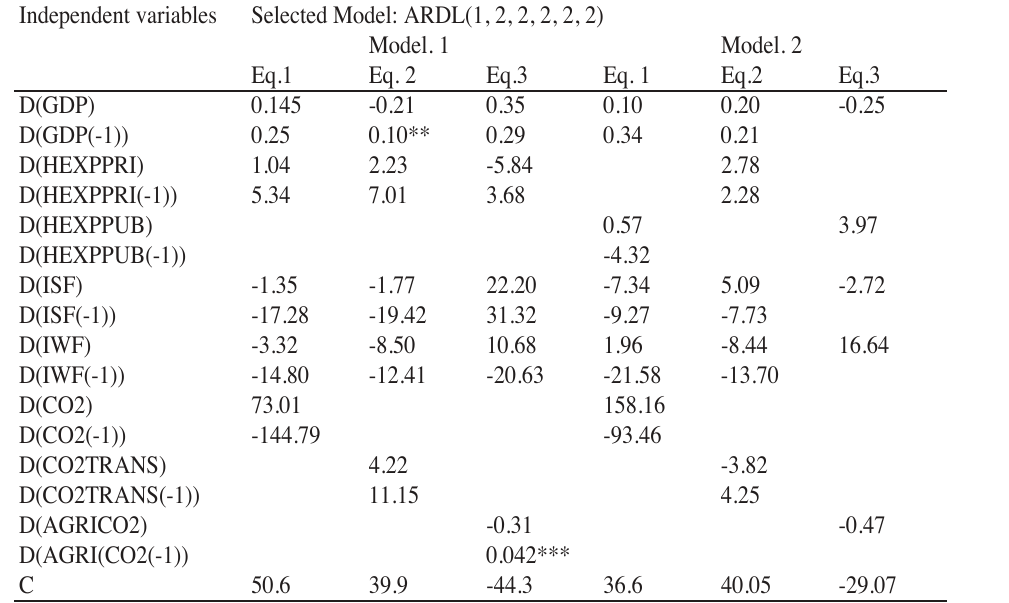
Table 6. Panel ARDL: Short Run Results (Dependent Variable: Child Mortality) Independent